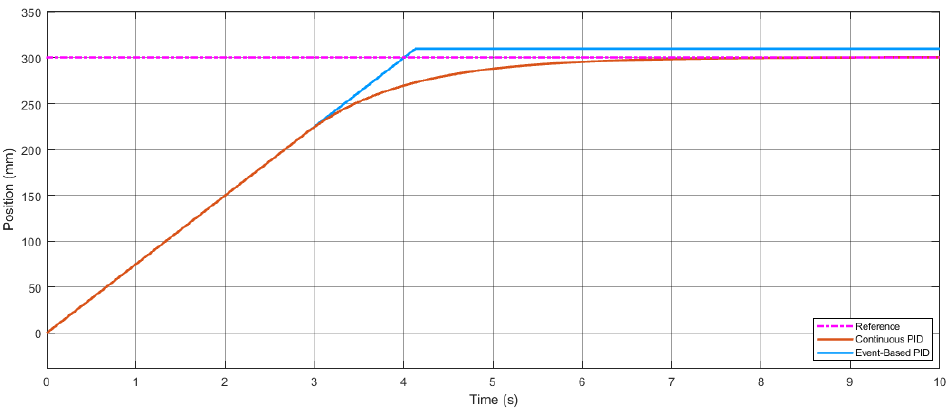
Figure 7. Event-based PID stationary error in the case of reference outside possible discrete points.